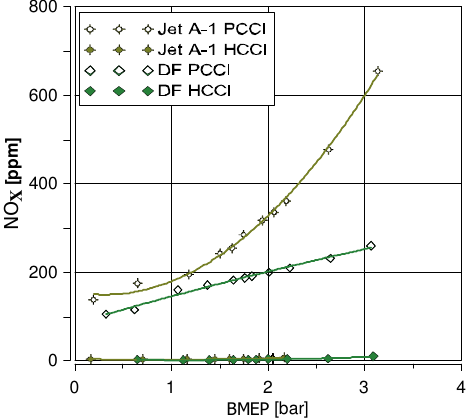
Fig. 8. NO x emission vs. BMEP for four modes of fuelling